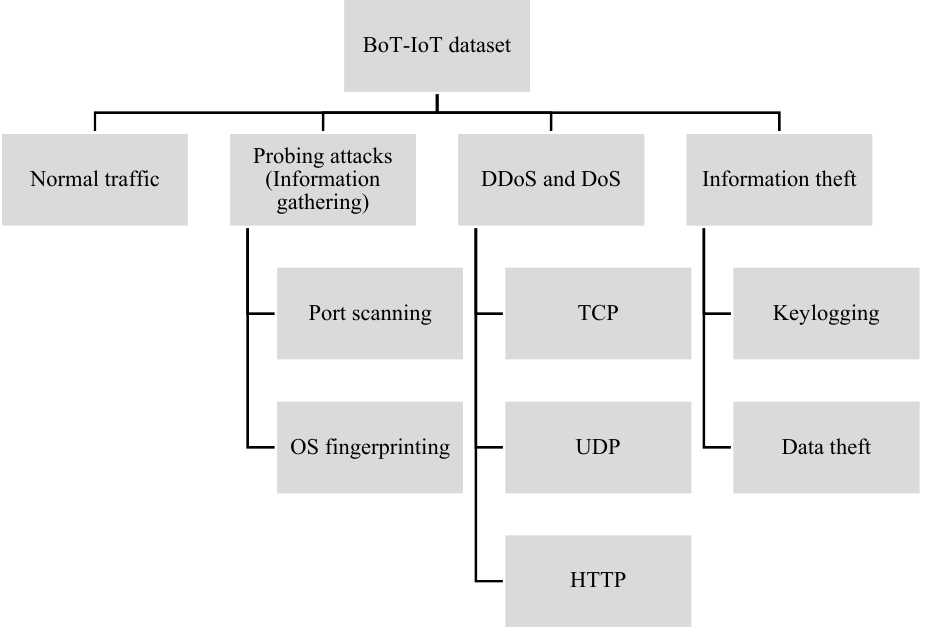
Figure 4. Composition of the BoT-IoT dataset. Table 3. Summary of original and extracted instances.